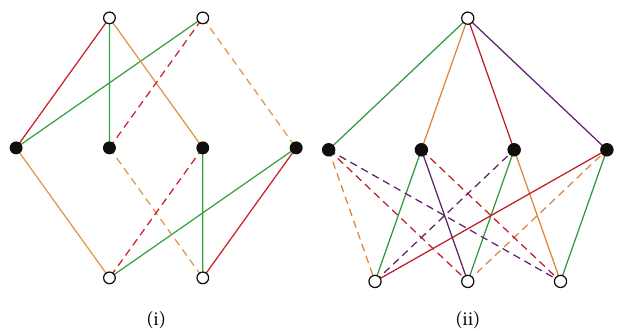
Figure 1: (i) A 3-cube Adinkra and (ii) a (4, 1)